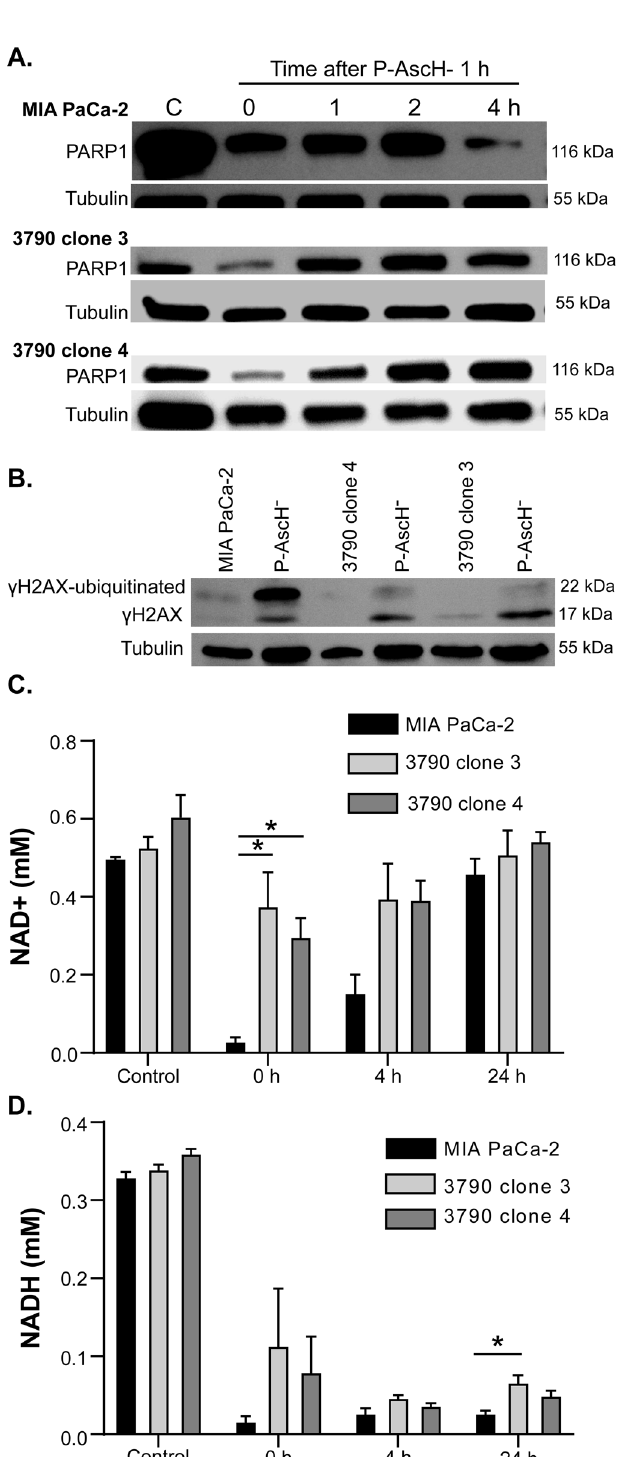
Figure 5. P-AscH - induced DNA damage and NAD + /NADH consumption is reduced in ρ 0 cells. ( A ) Western blot analyses demonstrate decreases in PARP1 at 4 h following exposure to P-AscH - (10 pmol cell −1 for 1 h) in MIA PaCa-2 cells and minimal changes in the two ρ 0 clones. ( B ) Western blot analyses demonstrate increases in phosphorylated γH2AX in MIA PaCa-2 cells following P-AscH - (14 pmol cell −1 ) treatment at for 1 h. In contrast the two ρ 0 clones had less phosphorylated γH2AX when compared to the parental cell line while all 3 clones had similar levels of γH2AX following exposure to P-AscH − . ( C ) Steady-state levels of NAD + are similar in the MIA PaCa-2 and ρ 0 clones. However, there is greater loss of NAD + immediately after P-AscH - treatment (0 h) in the MIA PaCa-2 cells (exposure: 6 pmol cell −1 for 1 h) compared to the ρ 0 clones. Levels of NAD + nearly recover to pretreatment steady-state levels 24 h after exposure to P-AscH - ( n = 3, means ± SEM; * p < 0.05, one-way ANOVA Tukey’s multiple comparison test). ( D ) Steady-state levels of NADH are similar in the MIA PaCa-2 and ρ 0 clones. However, there is greater loss of NADH immediately after treatment with P-AscH - (6 pmol cell −1 for 1 h) in MIA PaCa-2 cells than in ρ 0 cells. Steady-state levels of NADH do not recover to pretreatment levels ( n = 3, mean ± SEM; * p < 0.05, one-way ANOVA Tukey’s multiple comparison